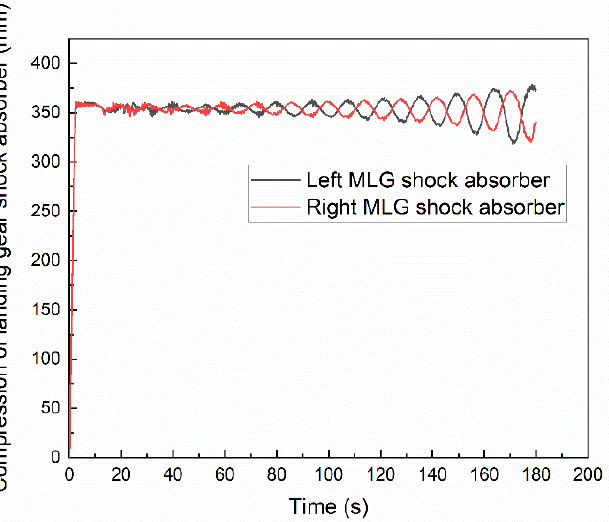
Figure 11. Compression of left and right MLG shock absorbers with torsional damping of 2400 N m s/rad.